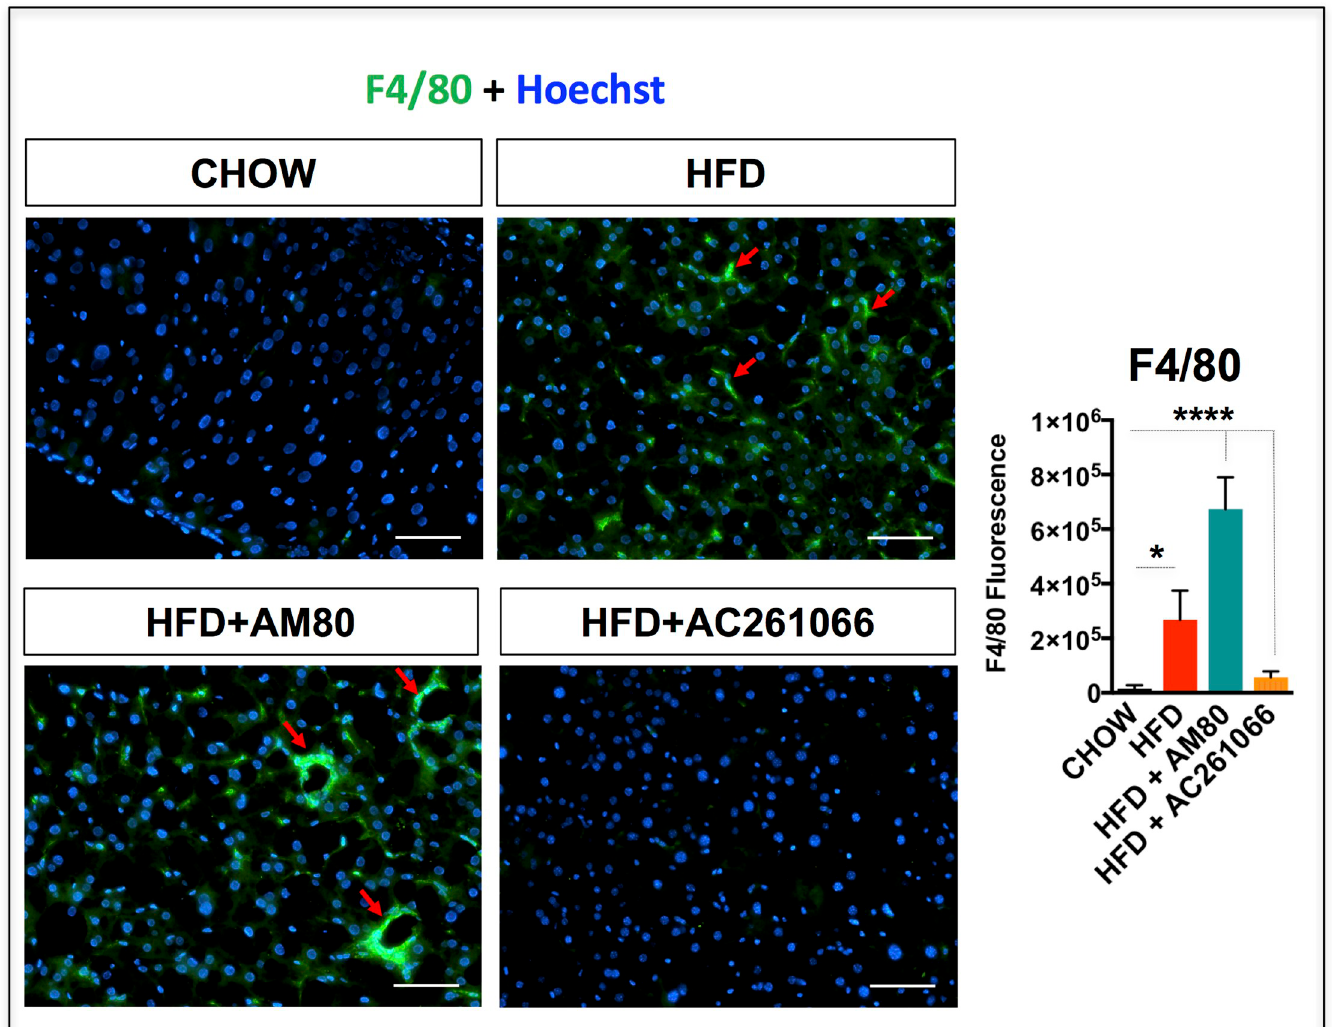
Fig 5. The RAR α -synthetic agonist AM80 increases levels of F4/80 in HFD-fed mice. Representative images depicting hepatic Kupffer cells stained with the F4/80 marker in green and nuclei in blue (Hoechst labeling) in chow-, HFD-, HFD+AM80-, and HFD+AC261066-treated mice assessed by immunofluorescence in frozen liver tissues. Red arrows indicate representative areas positive for F4/80. The plots are represented as mean ± standard deviation (SD); Mice per group = 4; Image fields measured per mouse > 4; Statistical significance is assessed by one way ANOVA (black stars), p < 0.05 = � ; p < 0.01 = �� ; p < 0.0001 = ���� . Magnification = 200X. Scale bar = 100 μ